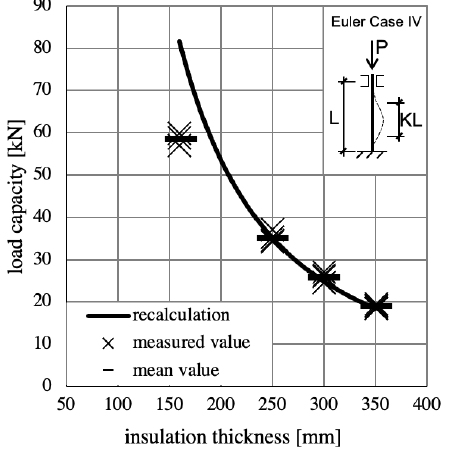
Figure 5. Experimentally and numerically deter- mined the load-bearing capacity of the connector un- der compression load as a function of the insulation